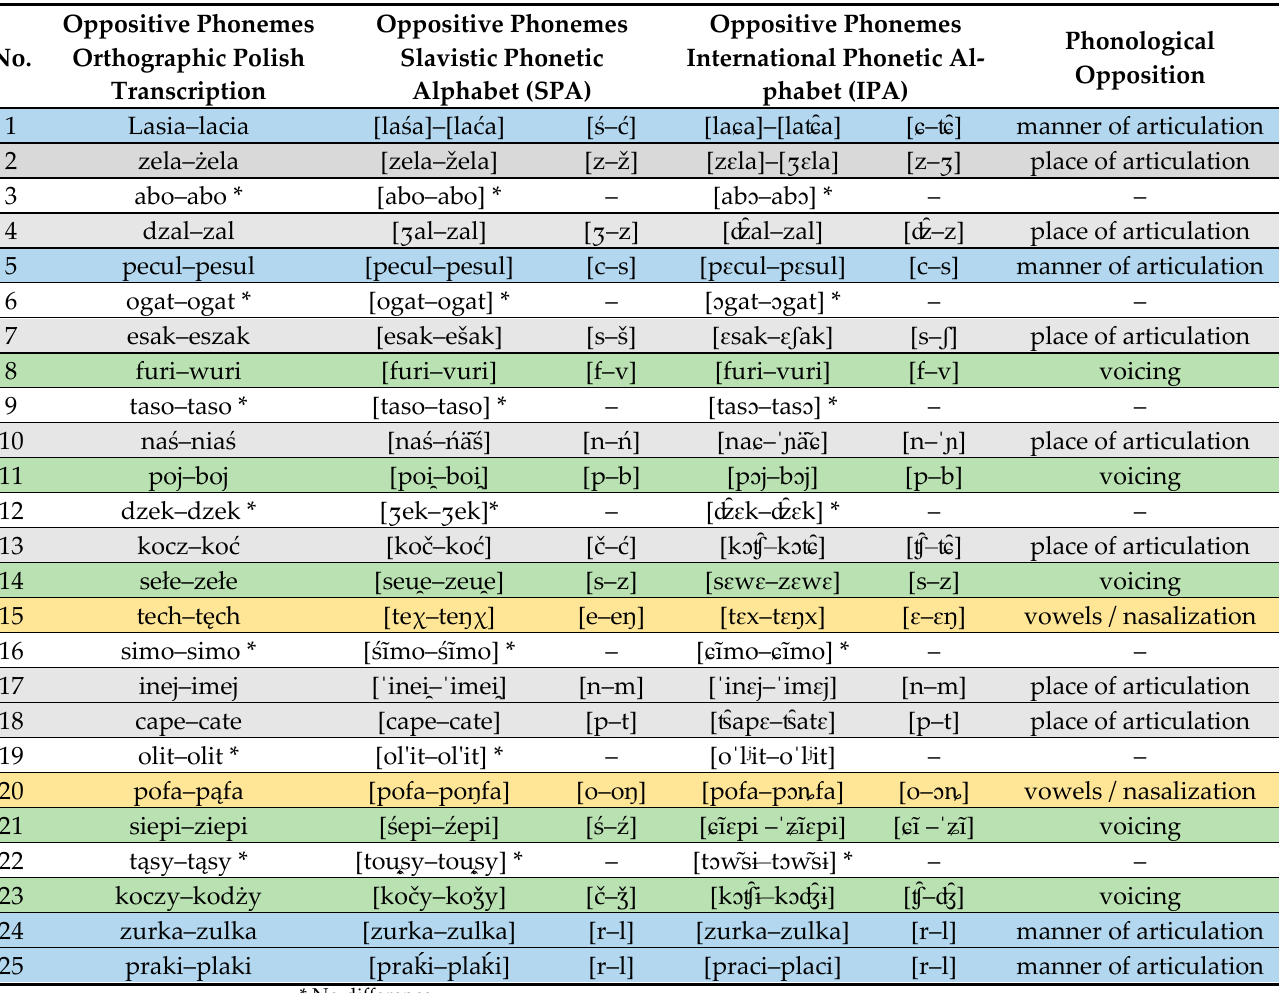
Table A1. A list of nonsense words to assess the ability to discriminate oppositional phonemes of the Polish language (autors’ own work).